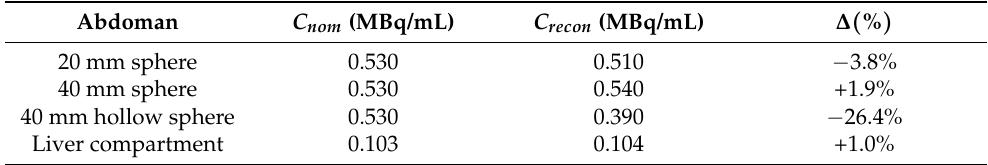
Table 1. Comparison between nominal ( C nom ) and reconstructed C recon activity concentrations related to the AbdoMan